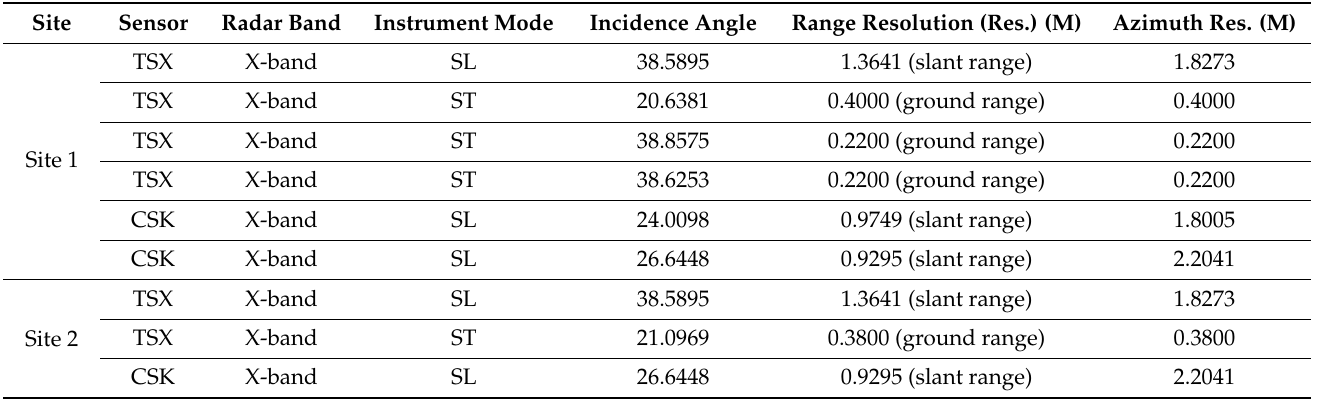
Figure 1. ( A ) Location of Tunisia relative to the world; ( B , C ) location of the study area in Tunisia; ( D ) 30 m resolution Advanced Spaceborne Thermal Emission and Reflection Radiometer (ASTER) global digital elevation model (GDEM) and hill shade of southern Tunisia showing the location of the archeological site; ( E ) slope map derived from the ASTER GDEM of the relief of Gafsa. Table 1. Summary of the TSX and CSK data used to develop the case studies examined in this paper. SL—spotlight; ST—staring